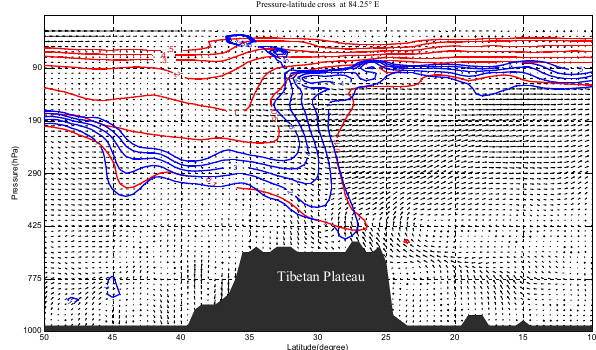
Fig. 6. (a) Pressure–latitude cross section of meridional wind vector (black arrow, m/s), ozone Fig. 6. Pressure-latitude cross-section of meridional wind vec- mass mixing ratio (red contours, 10 -6 kg/kg) and potential vorticity (PV) (blue lines, contours of tor (blue arrow, ms − 1 ), ozone mass mixing ratio (red contours, 1–5 PVU units) at 84.25 。 E (over Gerze site) on 25 Feb 2008, 12:00 LT between 10 。 N and 50 。 N in latitude and between 1000 hPa and 20 hPa in the vertical derived from ERA-40 data. The wind 10 − 6 kgkg − 1 ) and potential vorticity (PV) (blue lines, contours of vector shows meridional divergent wind (m/s) with vertical velocity (Pa/s) exaggerated by 60 times. 1–5 PVU units) at 84.25 ◦ E (over the Gerze site) on 25 Febru- ary 2008, 12:00LT between 10 ◦ N and 50 ◦ N in latitude and be- tween 1000hPa and 20hPa in the vertical derived from ERA-40 data. The wind vector shows meridional divergent wind (ms − 1 ) with vertical velocity (Pas − 1 ) exaggerated by 60